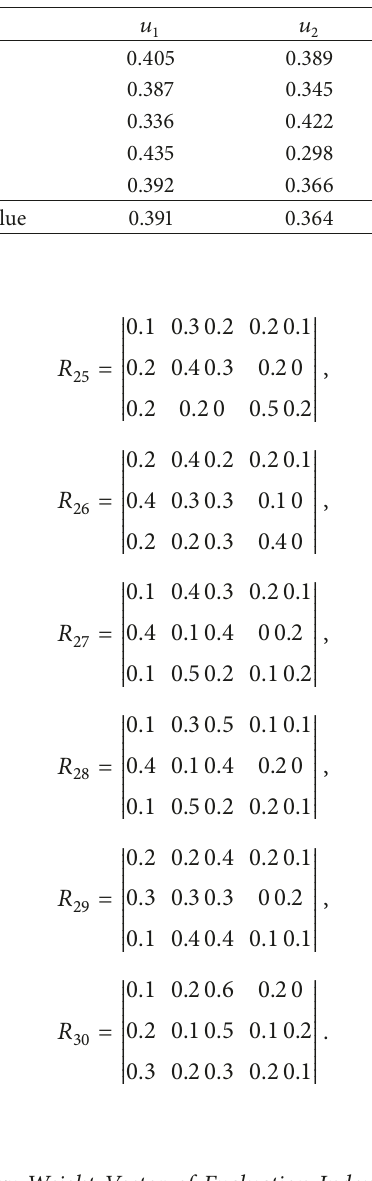
Table 4: Normalization results of the membership